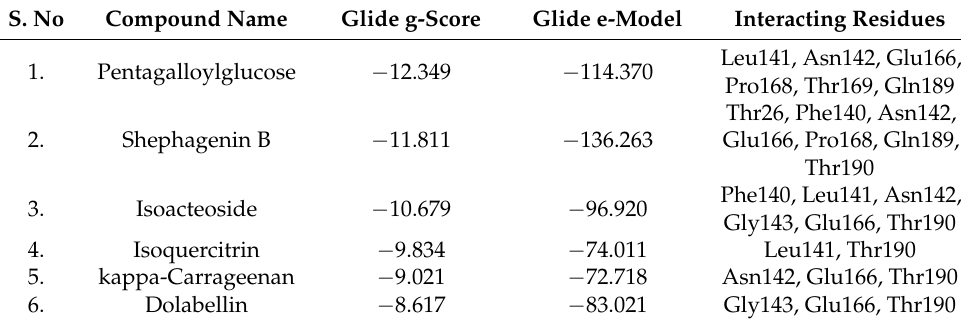
Table 1. Docking scores of six phytocompounds bound with the target M pro protein of SARS-CoV-2. These six phytocompounds are ranked according to their best docking scores.